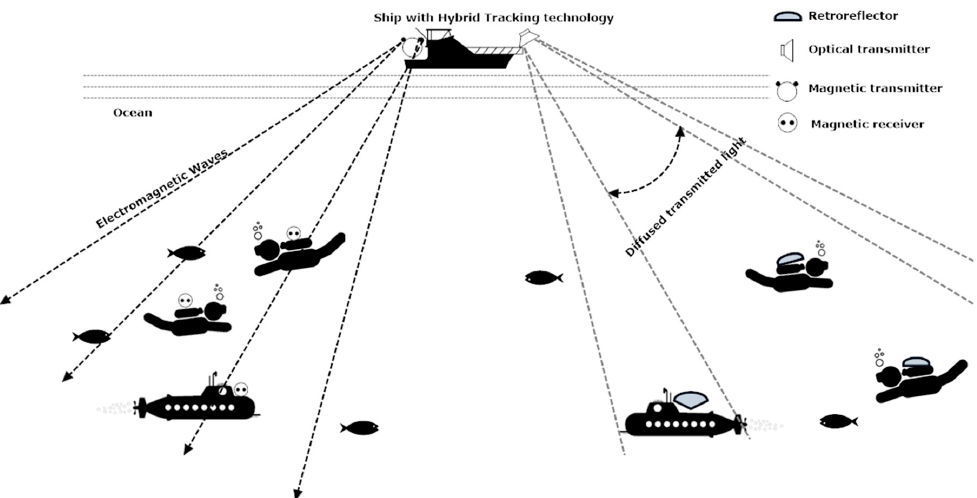
Figure 13. A hybrid model of optical and electromagnetic tracking-based aquatic communication.